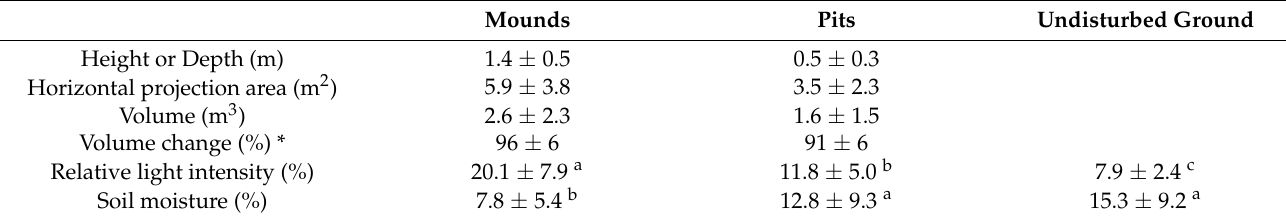
Table 2. Properties of the 39 microtopographic locations (mounds and pits) induced by the strong wind, and the undisturbed ground. The averages and standard deviations measured in the 2-nd growing season are shown.